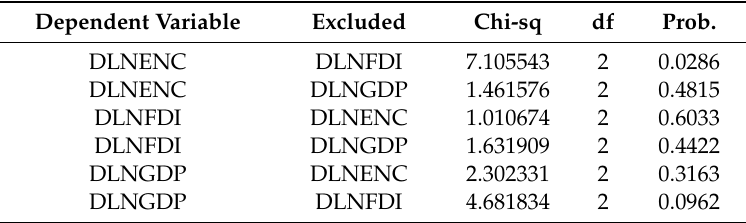
Table 10. VAR granger causality / block exogeneity Wald tests.